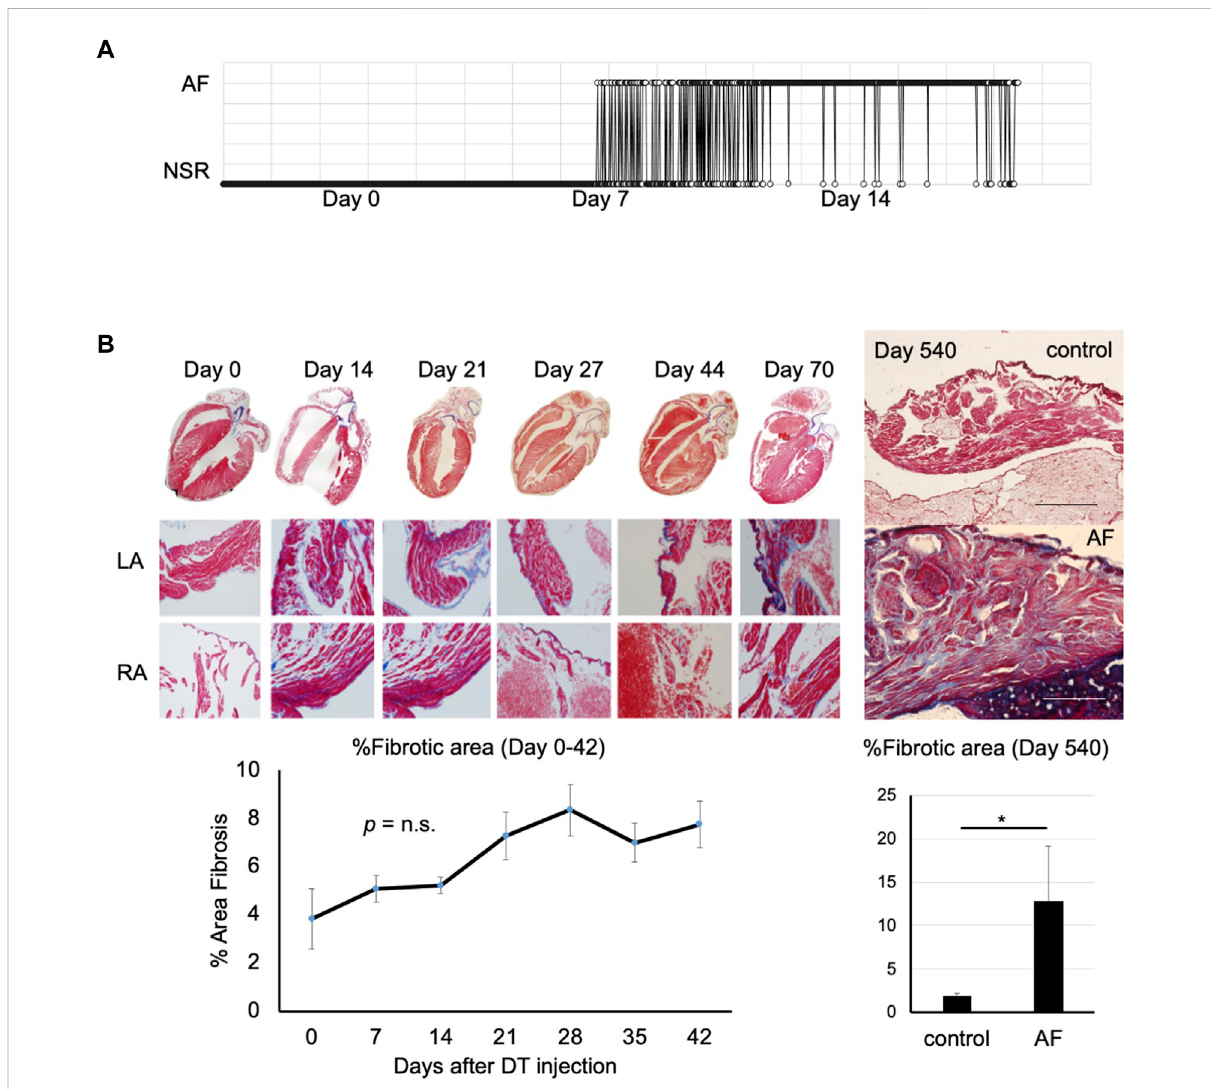
FIGURE 2 Progression of atrial fi brillation after induction (A) . Representative telemetry ECG indicating time in AF versus normal sinus rhythm ( n = 4). DT was injected at Day 0. This mouse started to show paroxysmal AF at Day 8. The duration of AF gradually prolonged over time. NSR, normal sinus rhythm. (B) .Masson ’ strichromestainingoftheatrialtissueofcontrol(left)andAFmouse(right)atDay0(pre-DT)toDay540post-DTinjection.Note severe fi brosis in AF mouse at Day 540. Scale bar = 500 μ m. Right panel shows the quanti fi cation of fi brotic area ( n = 3, each; * p <